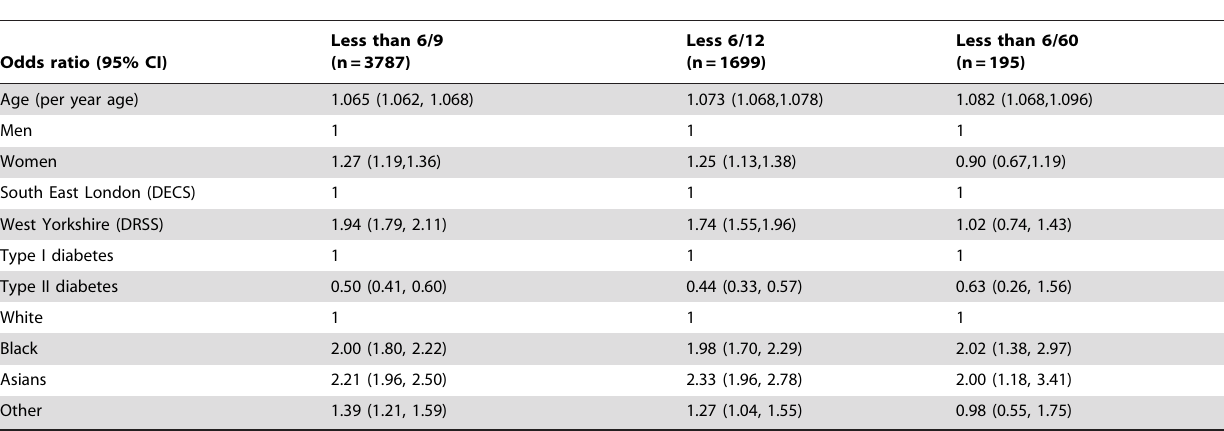
Table 5. Logistic regression analysis for each of the visual impairment categories.